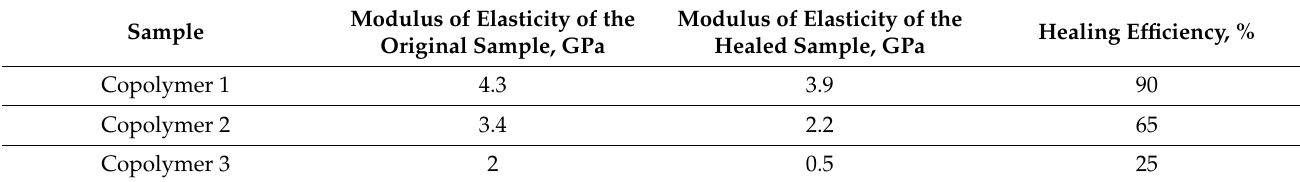
Table 5. Assessment of healing efficiency in relation to the modulus of elasticity.